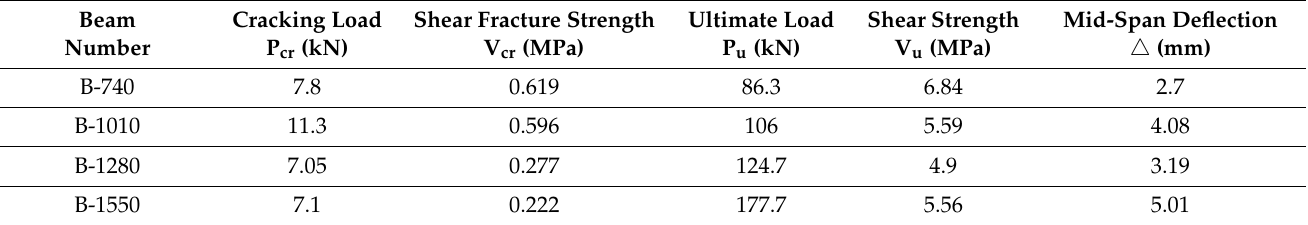
Table 7. Midspan deflection, shear capacity and shear strength of each beam.